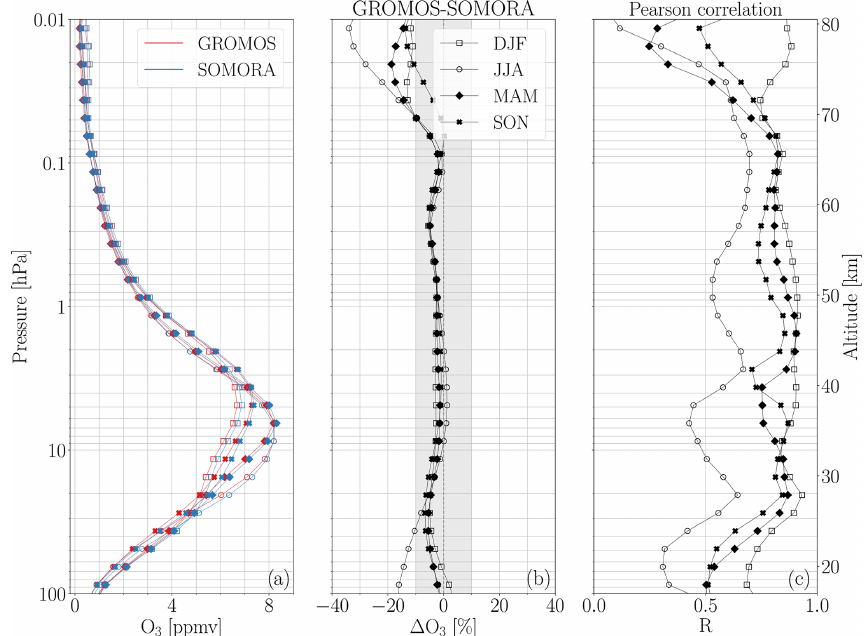
Figure 7. Mean seasonal ozone VMR profiles (a) and their mean relative differences (b) and correlations (c) . The shaded area in panel (b) indicates the ± 10%